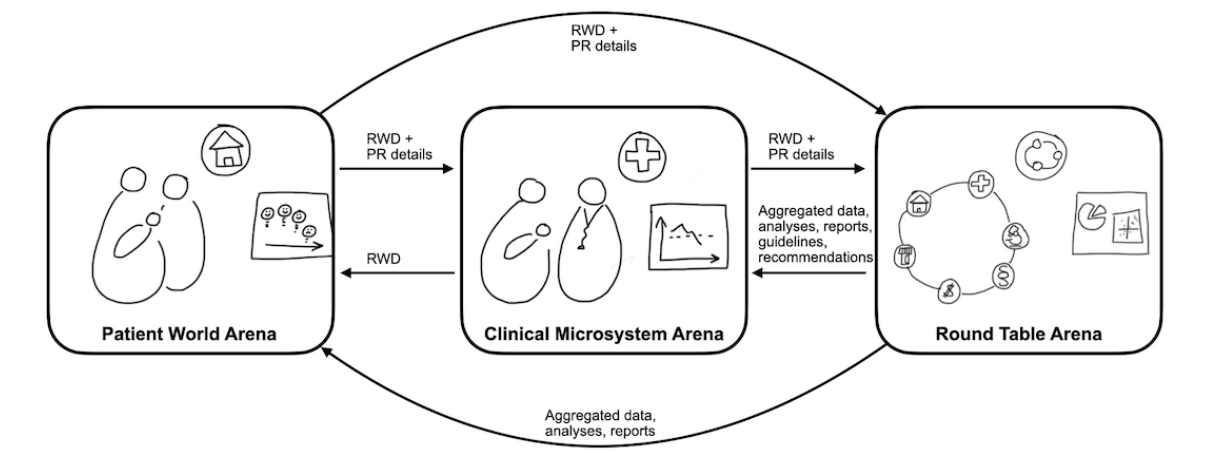
Figure 1. Three central arenas in the collection, use, and sharing of patient-controlled real-world data (RWD). PR details: specification of property rights that translate into use